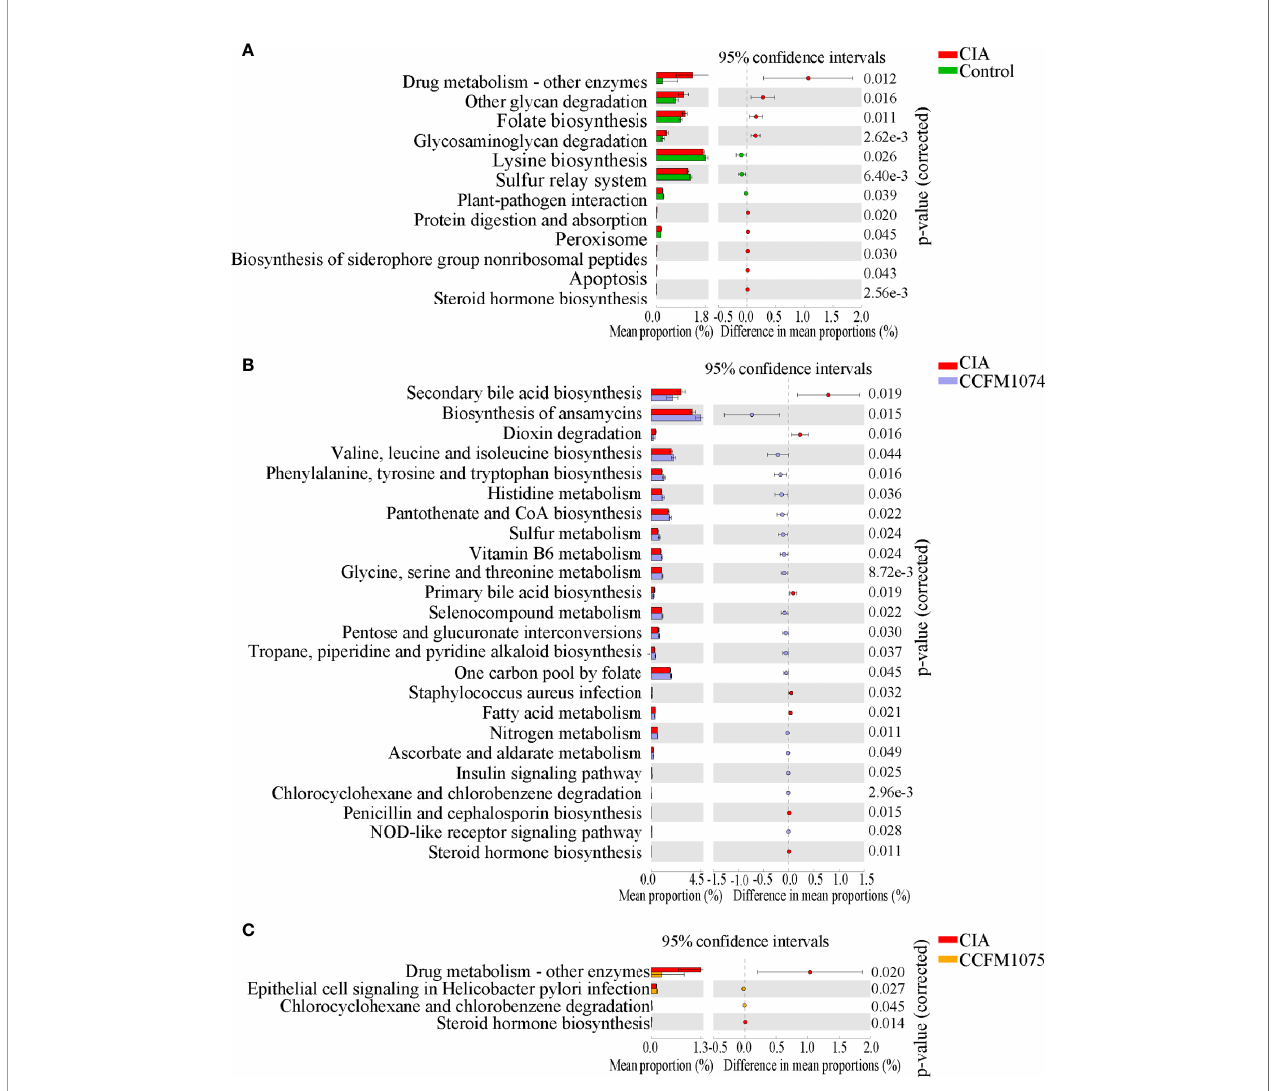
FIGURE 4 | Effects of L. casei on predicted metabolic pathways in CIA rats. The predicted metabolic pathways in Control (A) , CCFM1074 (B) and CCFM1075 (C) compared with CIA. control (vehicle-treated with saline 1.5 mL/day) group, CIA (vehicle-treated with saline 1.5 mL/day) group, methotrexate (MTX)-treated (6 mg/kg/ week) group, CCFM1074 (treated with CCFM1074, 8.5 × 10 9 CFU/day) group and CCFM1075 (treated with CCFM1075, 8.5 × 10 9 CFU/day) group, eight rats per group. Signi fi cant differences were tested using Welch ’ s t